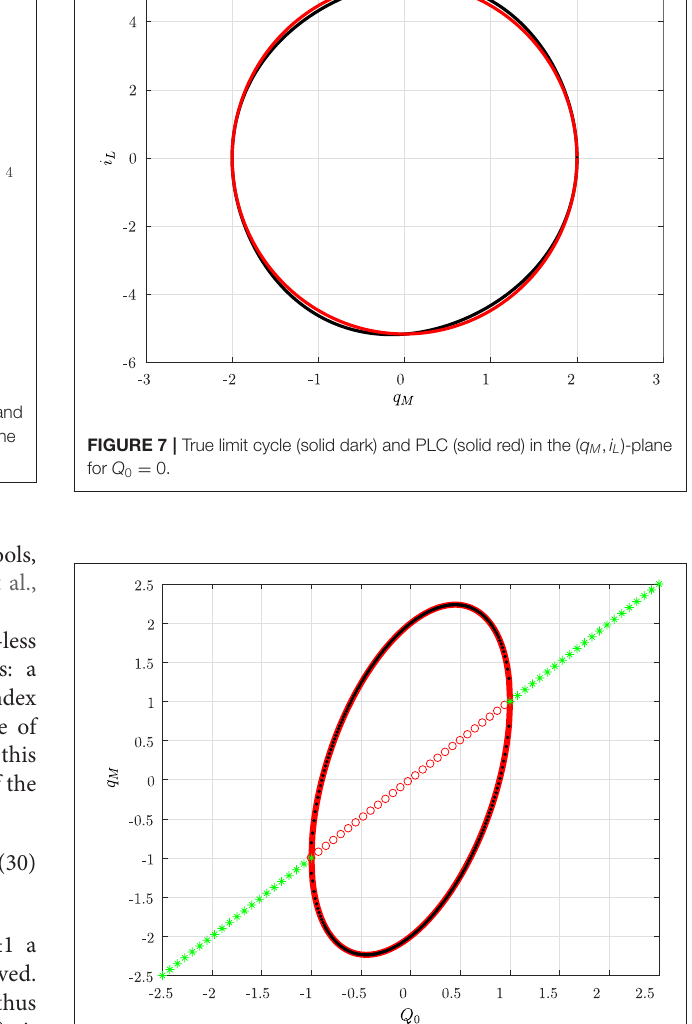
) equilibrium points; maximum ◦